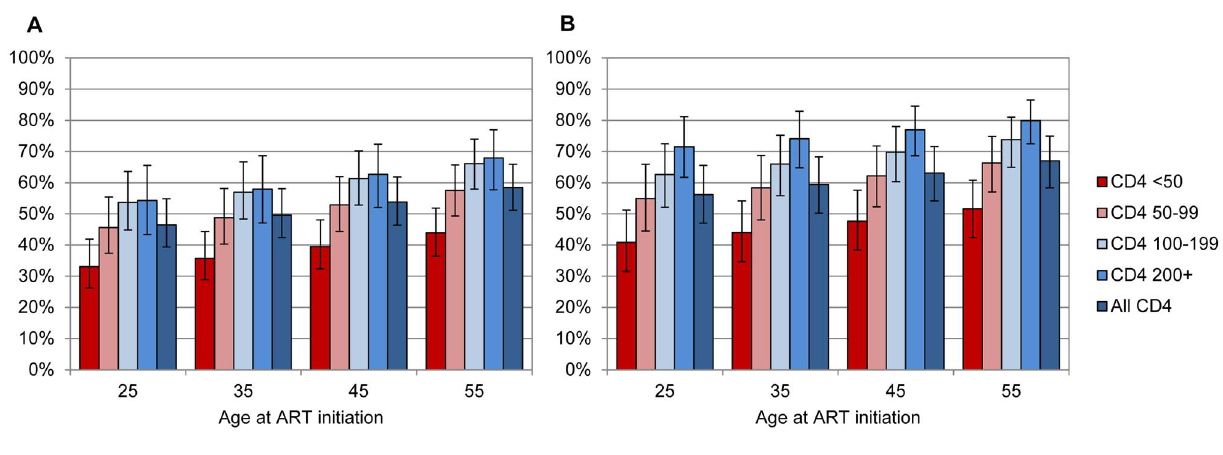
Figure 2. Proportion of individuals starting ART who are expected to die from causes unrelated to HIV. Proportions are plotted by age at ART initiation and baseline CD4 count, for men (A) and women (B). Bars represent means, and error bars represent 95% confidence intervals.